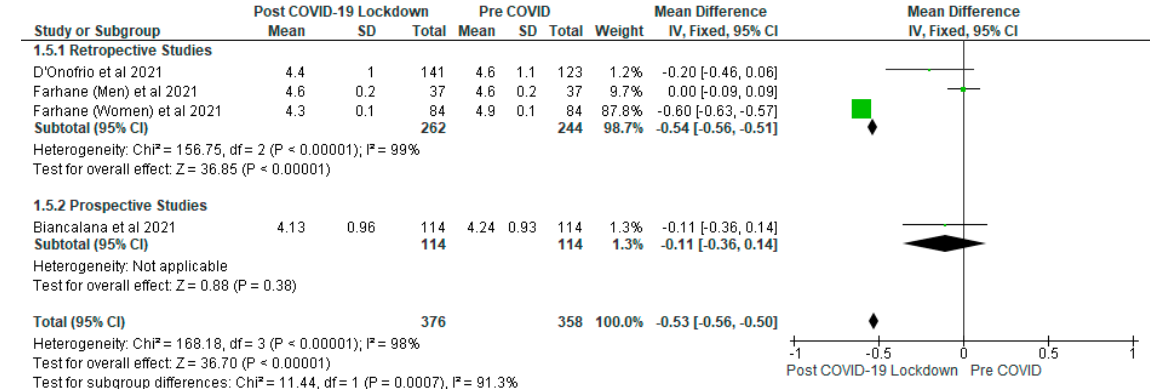
Figure 6. The effect of COVID-19 lockdown on Total Cholesterol (mmol/L). With respect to triglyceride (mmol/L), the mean difference between the post-COVID-19 lockdown gp and pre-COVID gp was − 0.06 (95% CI: − 0.09, − 0.04), involving 3 studies and 734 participants (post-COVID-19 lockdown gp, n = 376; pre-COVID, n = 358) (Figure 7).